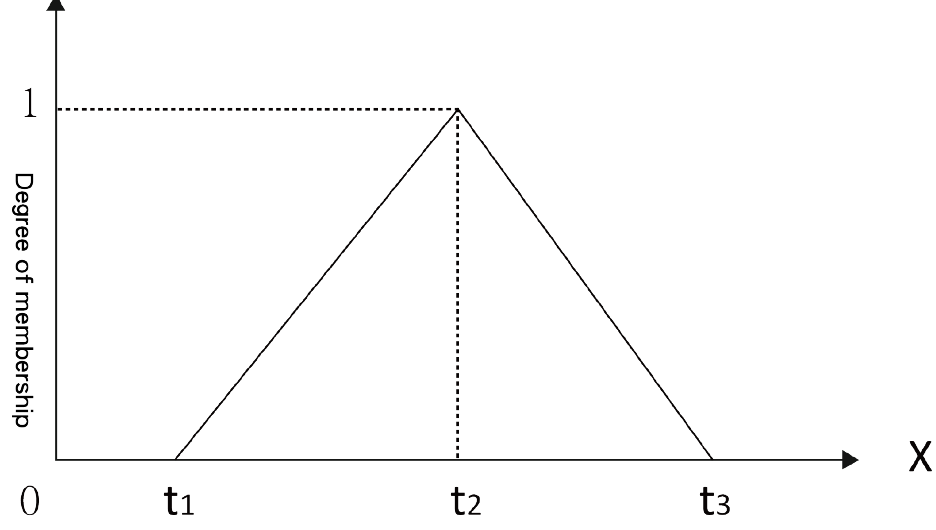
Figure 3. Membership function of a triangular fuzzy